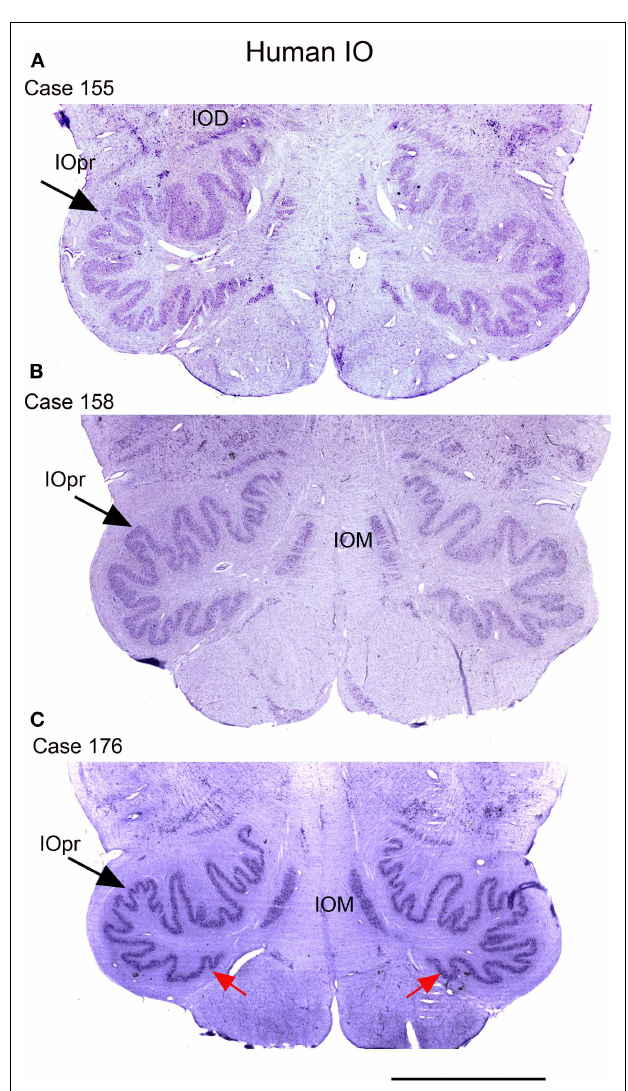
FIGURE 5 |The IO on CV sections of three different human cases . (A) Case 155, female, age 50. (B) Case 158, male, age 51. (C) Case 176, female, age 71. Note differences among cases in the size and shape of the principal nucleus of the inferior olive, IOpr (compare the IOpr shape at the large arrows). Also compare the left–right folding pattern; examples of different folding shown at the red arrows. IOD, dorsal nucleus of the inferior olive; IOM, medial nucleus of the inferior olive; IOpr, principal nucleus of the inferior olive. Scale bar 5mm.